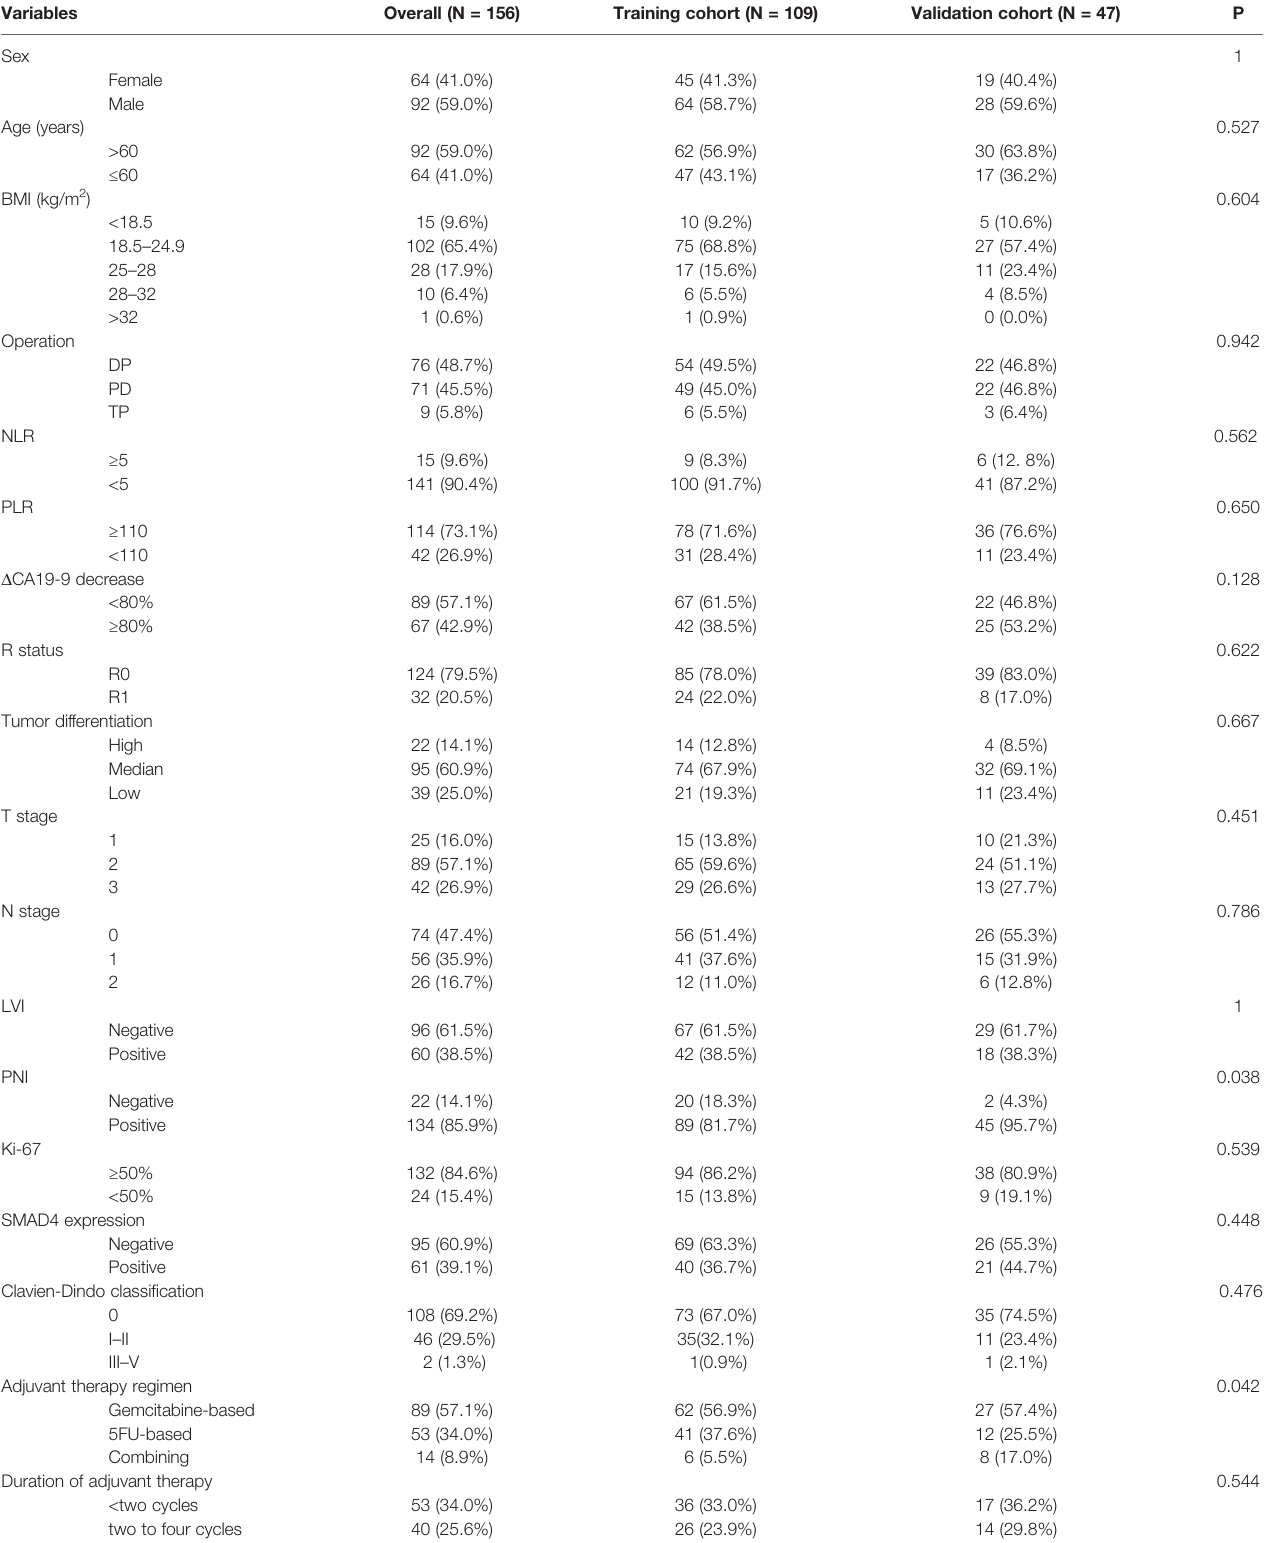
TABLE 1 | Clinical characteristics of resectable pancreatic cancer patients at baseline in the training and validation